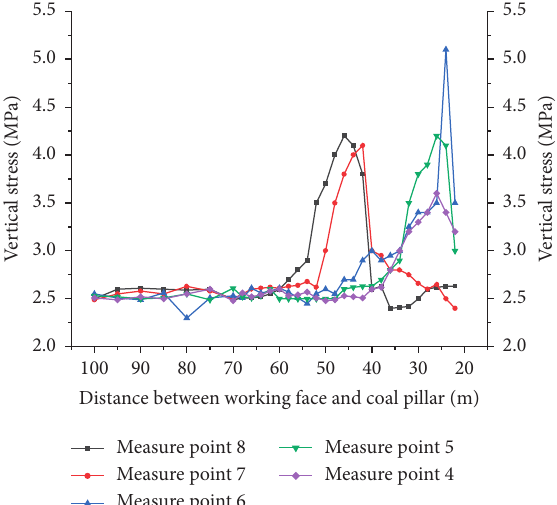
Figure 6: The vertical stress curve established based on the data collected from various monitoring